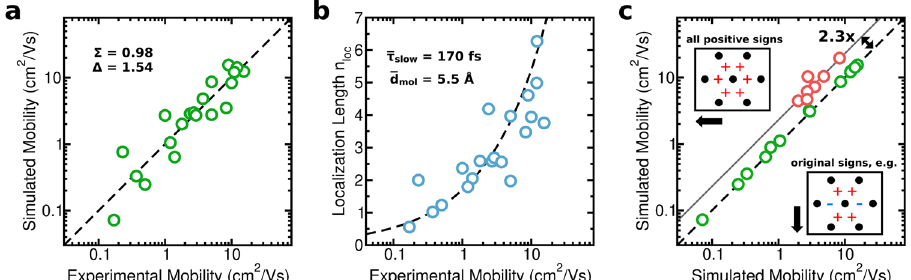
Fig. 4 Comparison of simulated and experimental hole mobilities. a Highest mobilities simulated in transport direction with the combined approach versus experimental mobilities. The black dotted line represents the case in which both coincide. b Experimental mobility versus the simulated localization length n loc = L loc / d mol ≤ in transport direction in units of molecular center-of-mass distances d mol . The black dotted line shows the dependency according to TL (Eq. (8)) using the stated averaged τ slow and d mol values. c Simulated mobility using the original signs of the transfer integrals ( x -axis) versus the simulated mobility by using all positive signs for the transfer integrals ( y -axis). Materials that show a large increase of the mobility (of in average a factor of 2.3) due to the sign change are highlighted in